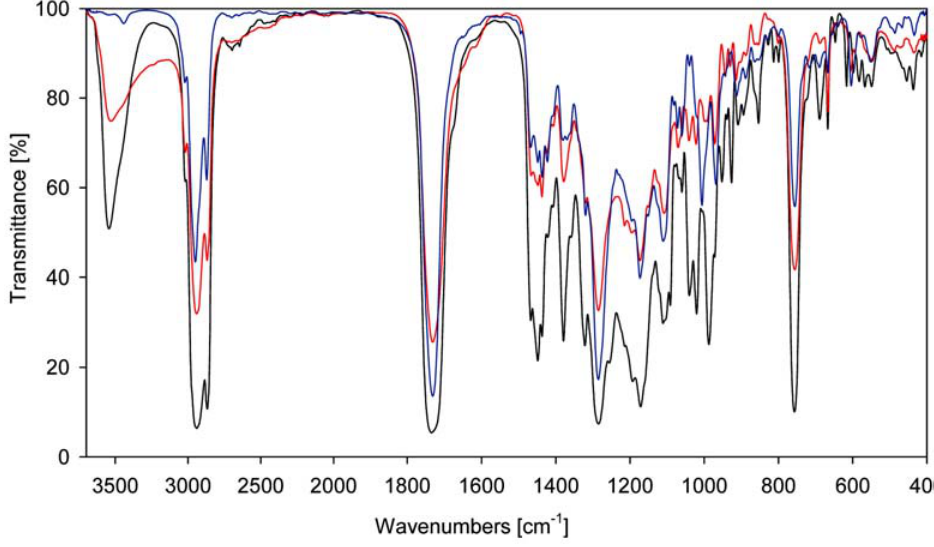
Figure 6. FT-IR spectra (film) of compounds 7 (black), 9 (red) and 10 (blue) in the 3600–400 cm –1